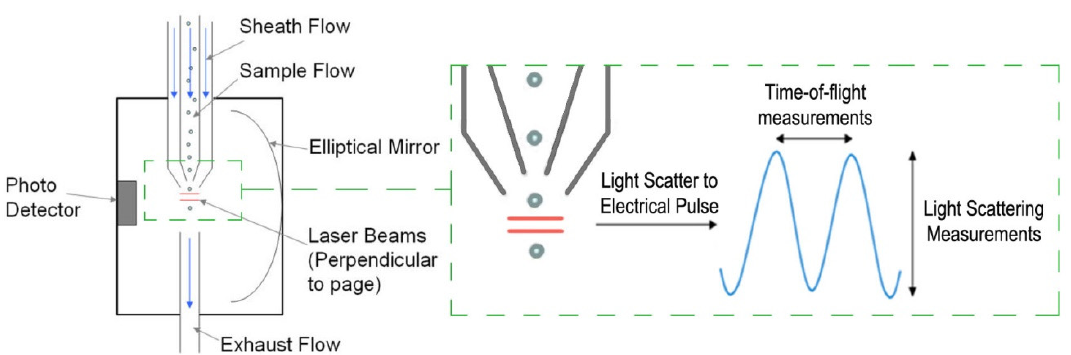
Figure 2. Aerodynamic Particle Sizer (APS) operation scheme and a detailed view with aerosol droplets crossing the overlapping breams and generating the double-crested signal.